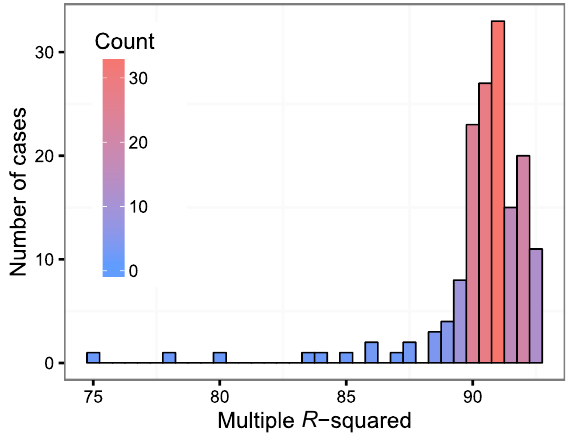
R Figure 4: Histogram of multiple R -squared of ALI Band 1’, 1, 2, 3, 4, 4’, 5’, 5, and 7, respectively; and ε ij is random error (residual) at band i and location j